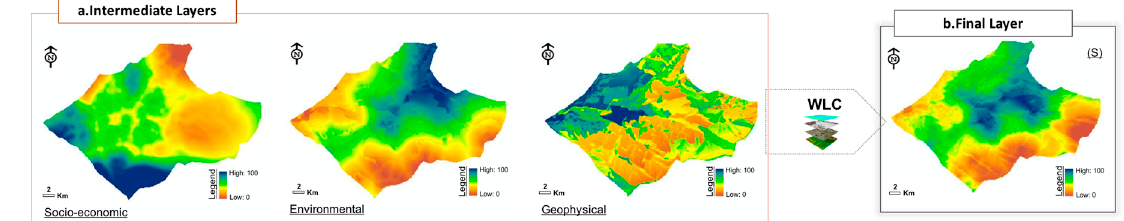
Figure 5. Process of final suitability map (S) with multicriteria GIS-MCDA evaluation of location optimization for biomass facility in the case study region: ( a ) Intermediate layers and ( b ) Final layer.